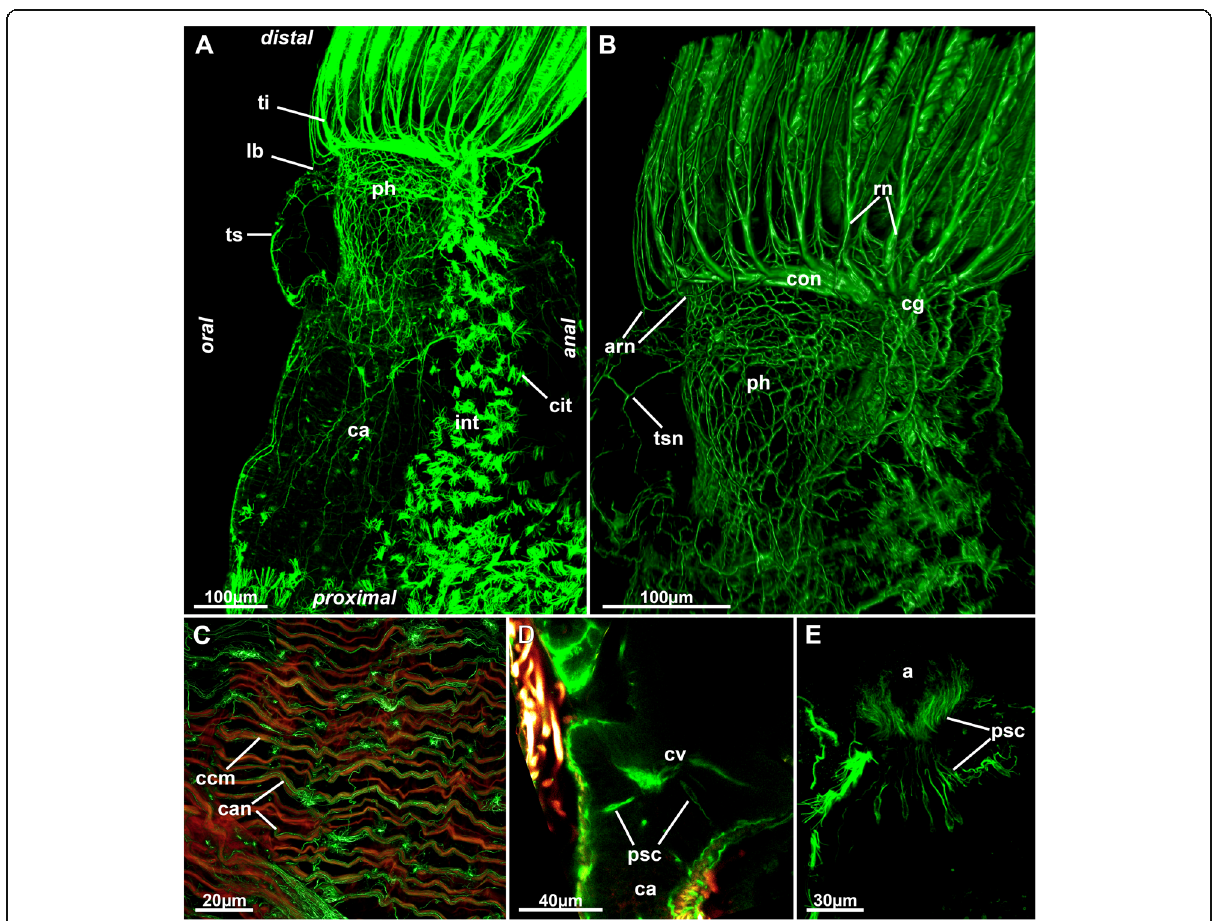
Fig. 16 Nervous system of the digestive system of Stephanella hina . Confocal laser scanning microscopy stacks based on acetylated alpha-tubulin labelling. Volume renderings, projection or optical slices. Acetylated alpha-tubulin in green LUT, f-actin in glow LUT. a General overview of an extended polypide showing dense innervation of the foregut. Note also the dense ciliary bundles on the anal side of the intestine. b Details